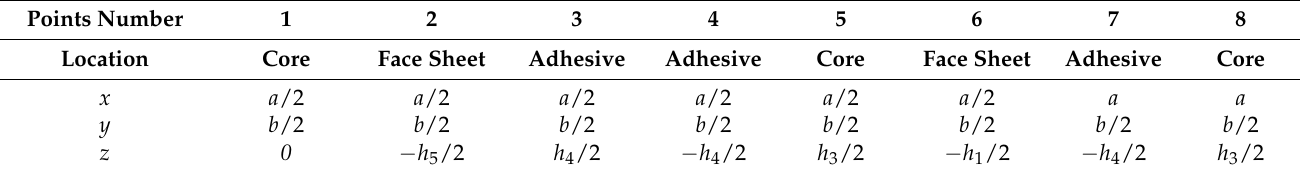
Table 5. The geometric positions for 8 points are defined in tables according to the coordinate system is shown in Figure